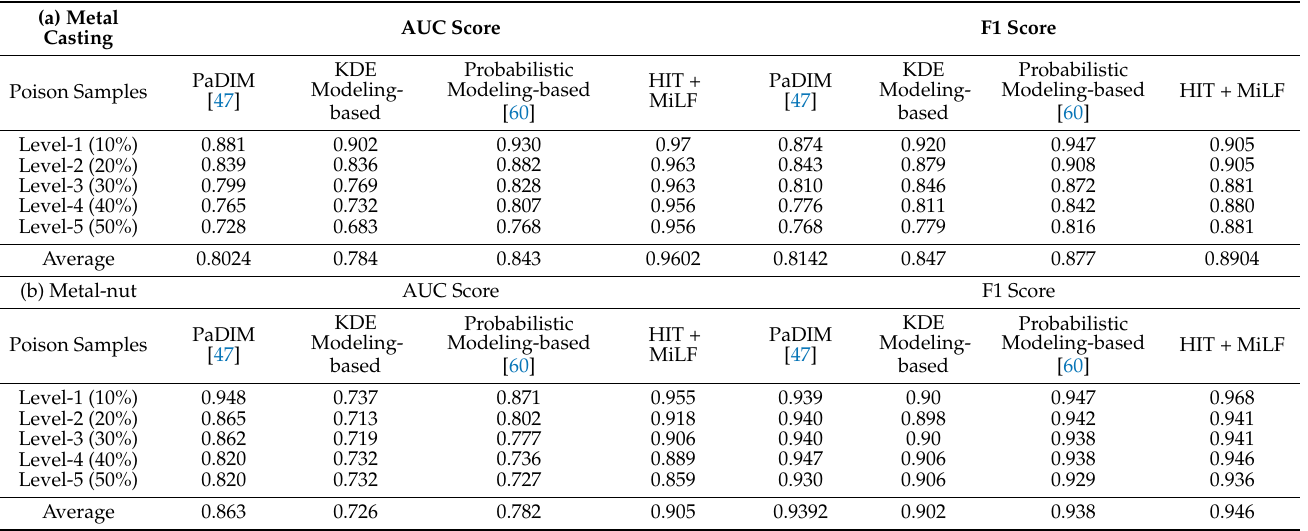
Table 6. Comparison results with other deep features-based methods on Metal casting and Metal- nut